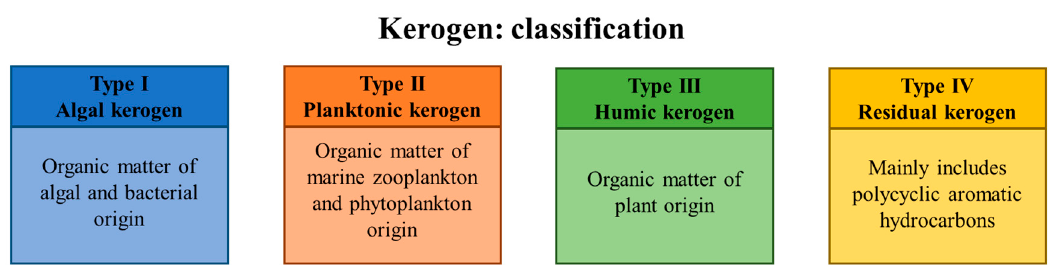
Figure 1. Classification of kerogen types based on their origin.